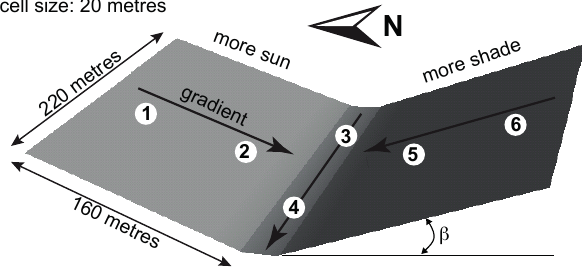
Figure 4. Synthetic catchment and location of points analysed. The converging topography has a sun-exposed and a more shaded side. It is varied with respect to the inclination angle of its hillslopes β . Channel inclination, in the direction from point 3 to 4, is always 5 ◦ .